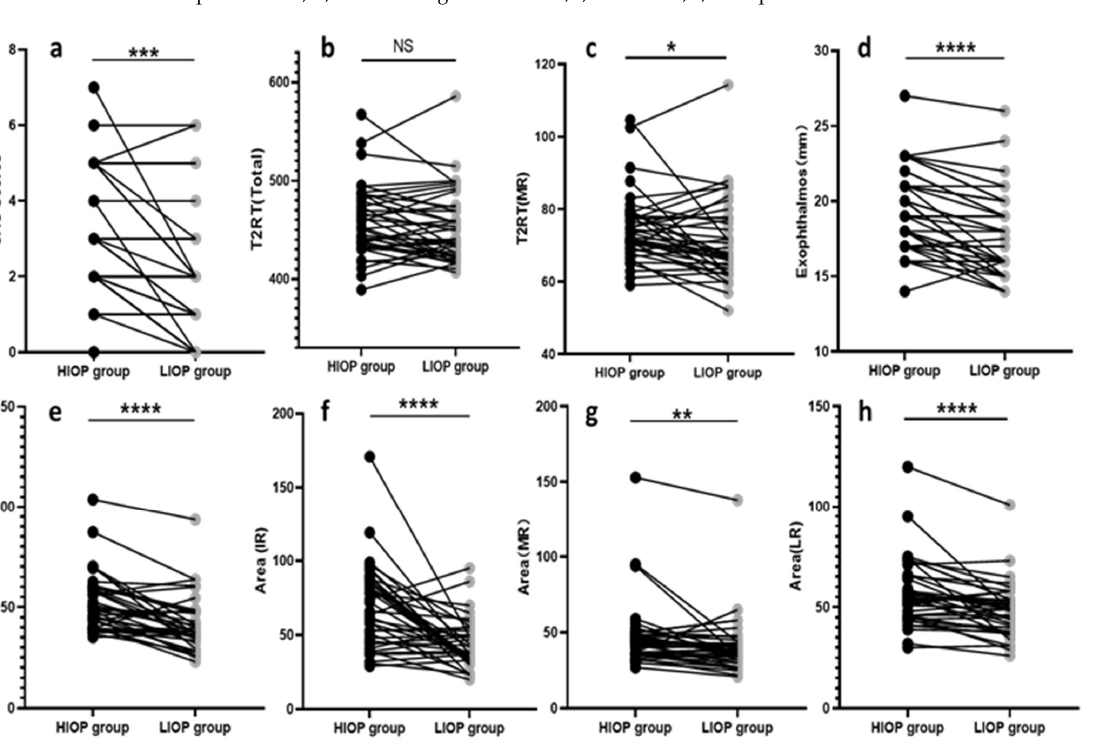
Table 3. Correlation analysis between IOP and CAS, exophthalmos and OMR parameters. Parameters